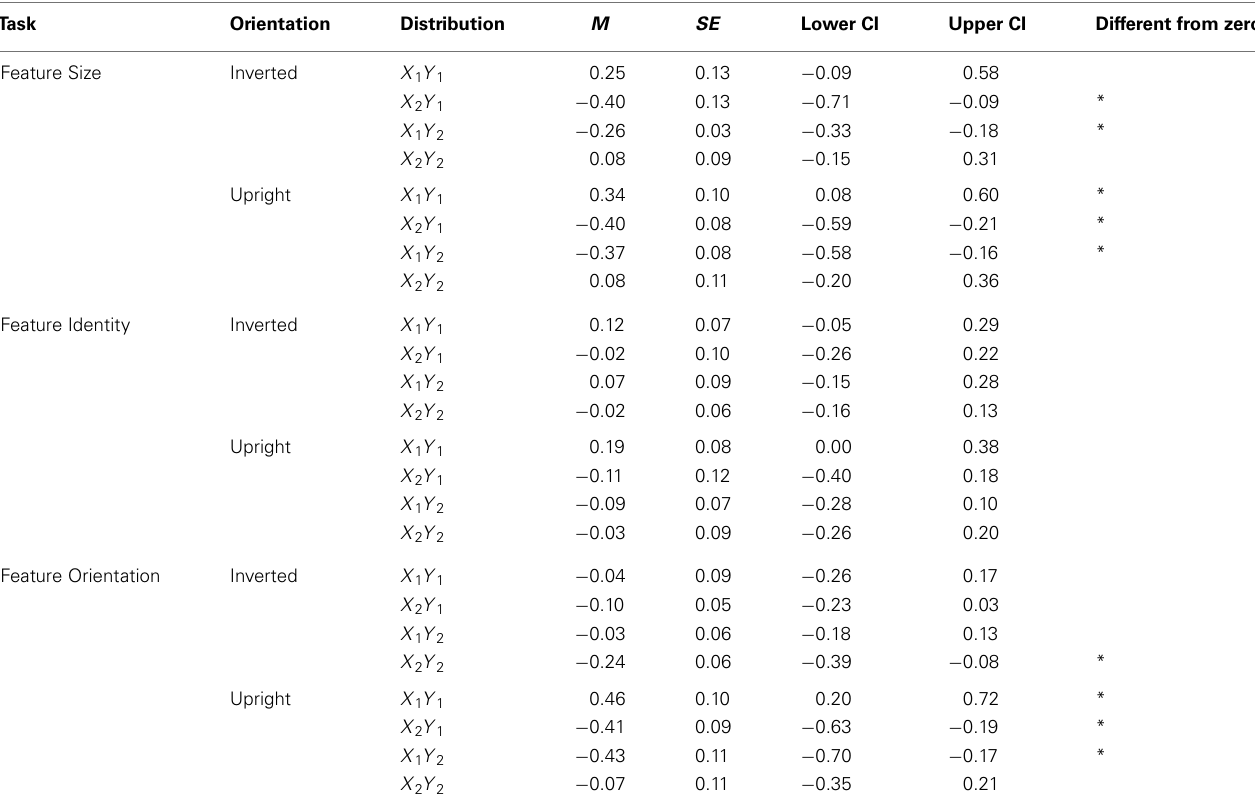
Table 2 | Mean correlation for each distribution in each task condition with 95% confidence intervals.